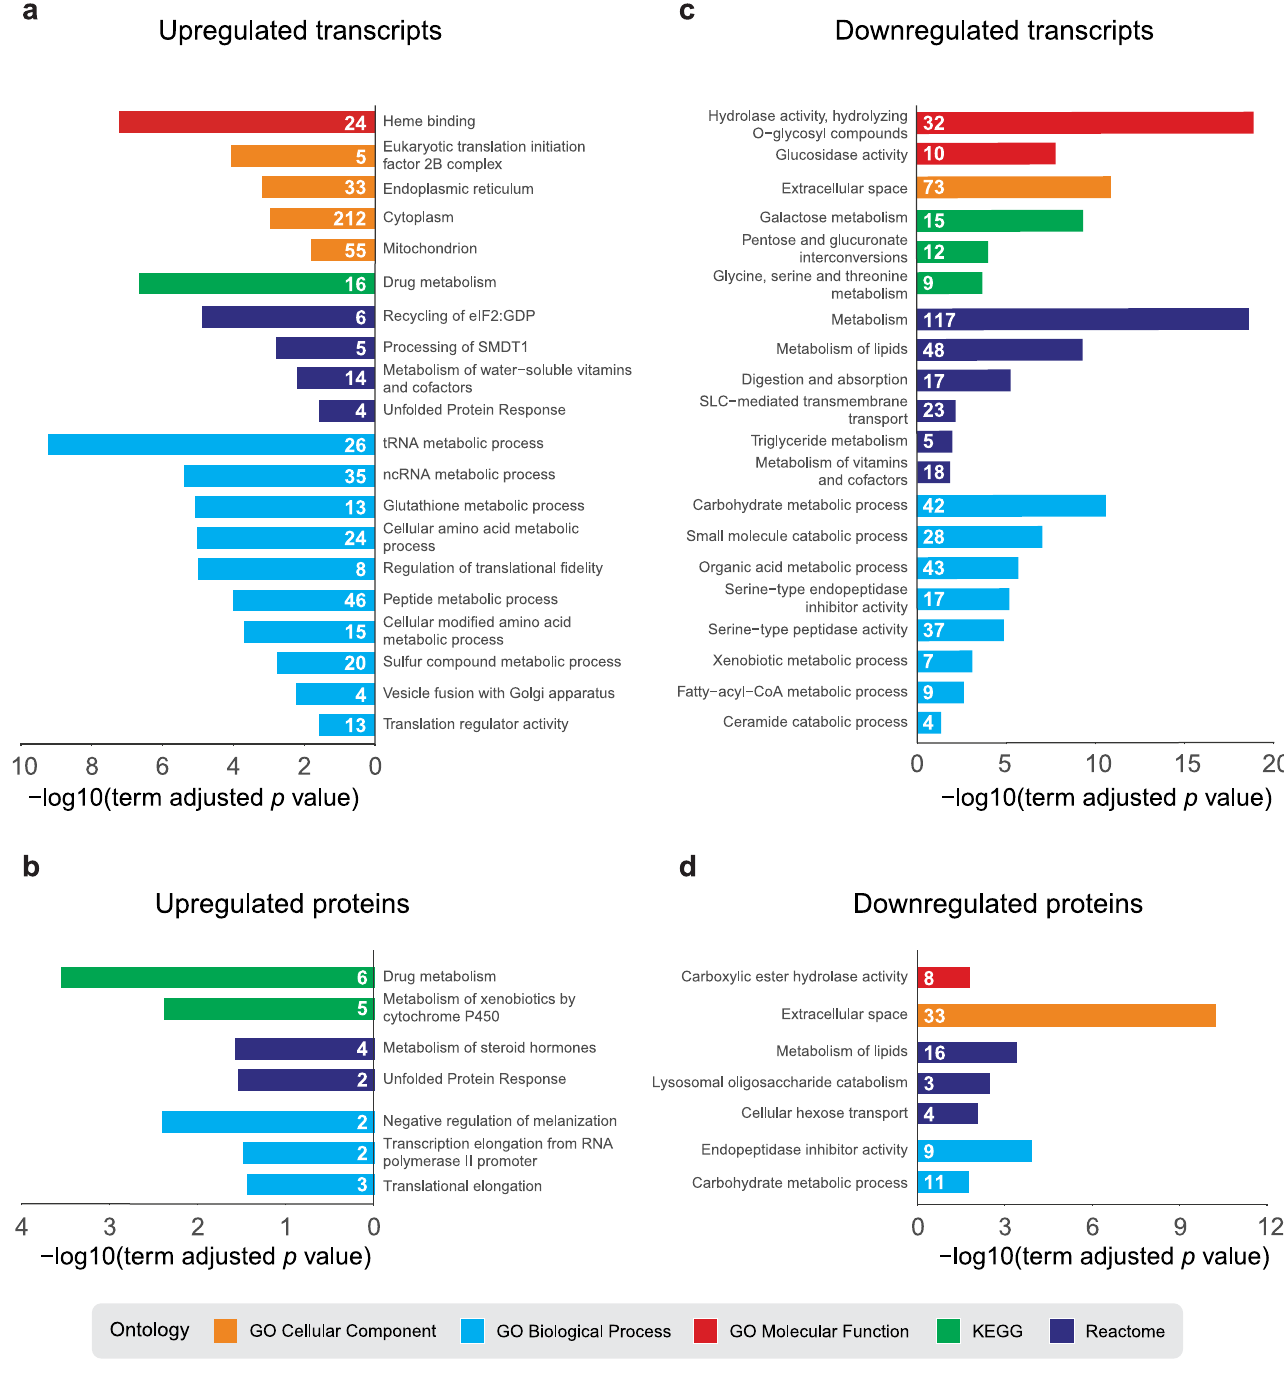
Figure 3. dPerk-dependent global expression changes. ClueGO pathway enrichment analysis (PEA) of differentially regulated molecules. Selected results from the Gene Ontology (GO) Cellular Component, GO Biological Process, GO Molecular Function, KEGG and Reactome, ontology terms and their respective − log10 (adjusted term p -value) are shown. The number of associated molecules of a specific functional term is displayed on the bars. ClueGO PEA of upregulated transcripts ( a ) and proteins ( b ). ClueGO PEA of downregulated transcripts ( c ) and proteins ( d